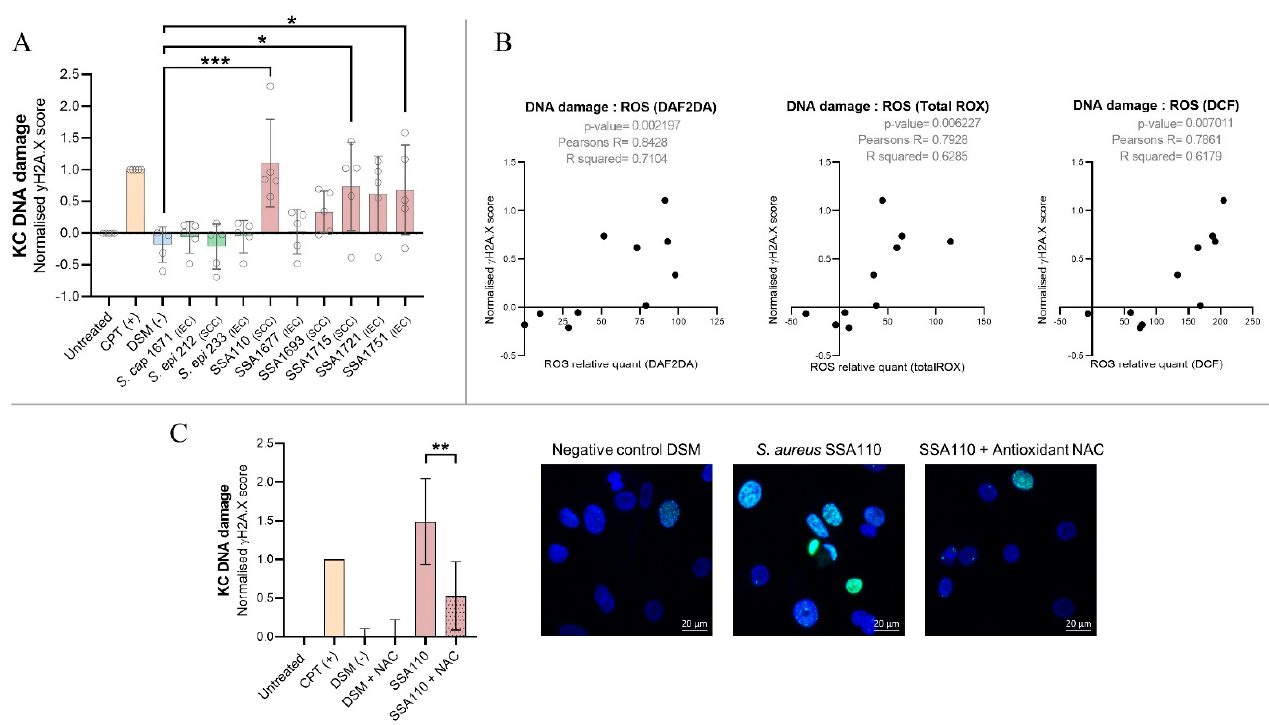
Figure 5. S. aureus causes keratinocyte DNA double strand breaks, and S. aureus secretome-induced ROS levels positively correlate with genotoxicity in human keratinocytes. ( A ) Primary human keratinocytes from five different donors were grown on coverslips in technical duplicates and exposed to the secretomes prepared from Staphylococcus species isolated from intraepithelial carcinoma (IEC) or squamous cancer (SCC) skin for 6 h. Negative controls included no treatment and Staphylococcus culture media (DSM). Positive control was the DNA breakage promoting drug camptothecin (CPT, 10 μ M). Histone H2A.X phosphorylation ( γ H2A.X, green) was measured via immunofluorescence staining as a measure of DNA double strand breaks. DAPI (blue) was used to stain the nuclei. Images were captured at 63× magnification by confocal microscopy (representative images are shown in panel C. The number of foci per cell was enumerated and calculated to a score normalized to the control (0) and positive control CPT (1). Statistical significance was determined by Dunnett’s multiple comparisons test (* p < 0.05; *** p < 0.001). ( B ) Pearson’s correlation analysis was conducted to examine the correlation between keratinocyte intracellular ROS and DNA damage induced by Staphylococcal secretomes. ( C ) To determine if S. aureus -induced DNA damage in keratinocytes is ROS-mediated, primary human keratinocytes from two different donors were exposed to the genotoxic S. aureus secretome from isolate SSA110 +/ − antioxidant N-Acetyl Cysteine (NAC, 2 mM). Statistical significance between SSA110 and SSA110 + NAC treated cells was determined by paired t -test (** p = 0.0025).